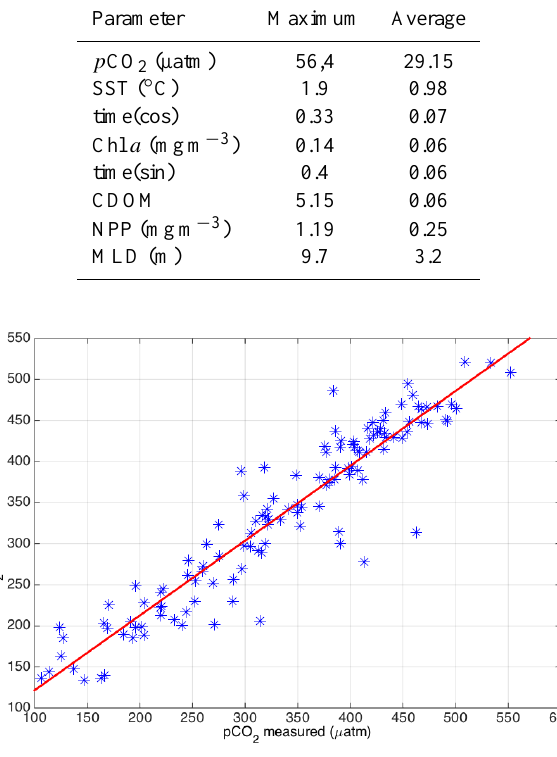
Figure 12. p CO 2 reconstructed in function of the measured. The red line represents the linear relationship. The data represent 10% of the total of data used for the validation data